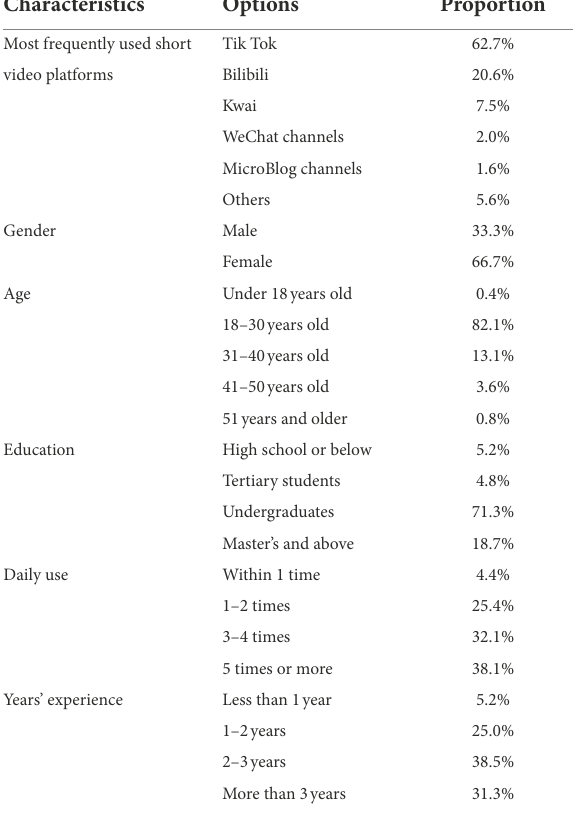
TABLE 1 Description of the valid sample